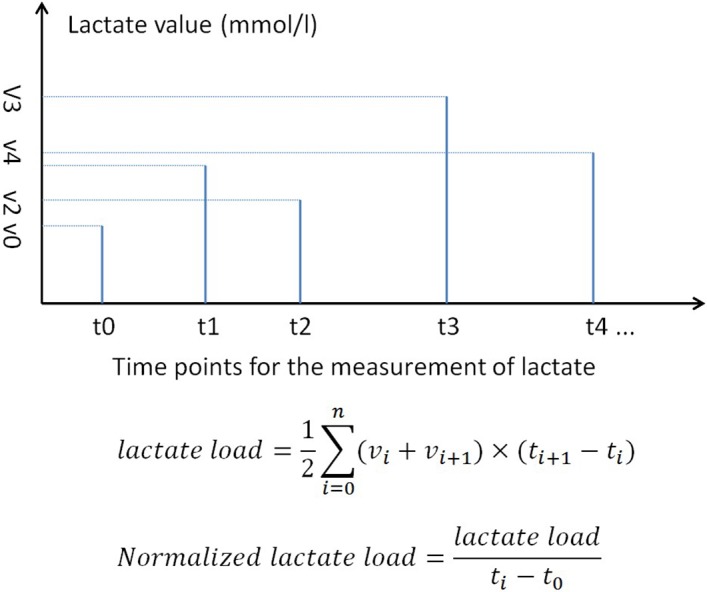
Schematic illustration of the calculation of lactate load and normalized lactate load.